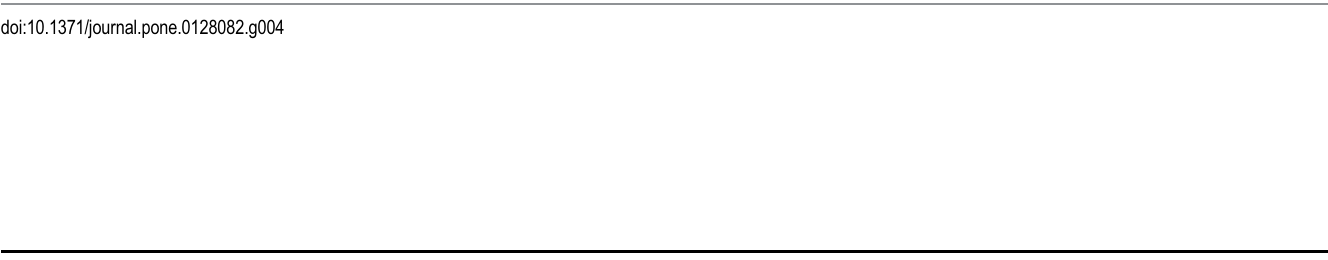
PLOS ONE | DOI:10.1371/journal.pone.0128082 May 26,